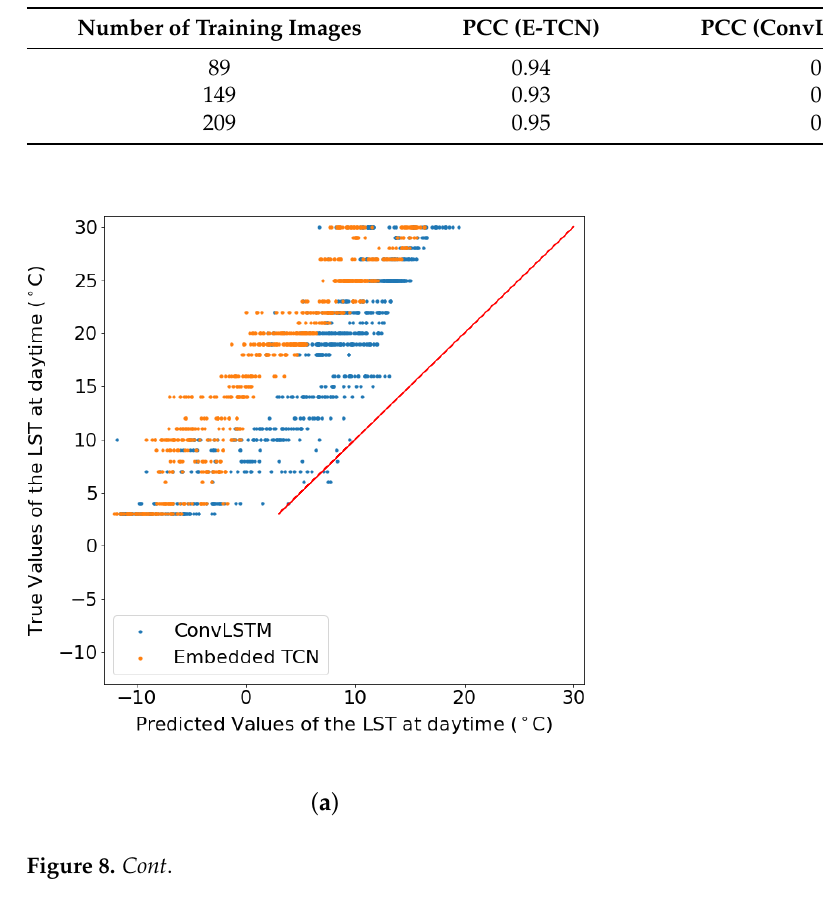
Table 3. PCC for different number of training images as resulted by using the E-TCN and the ConvLSTM model.